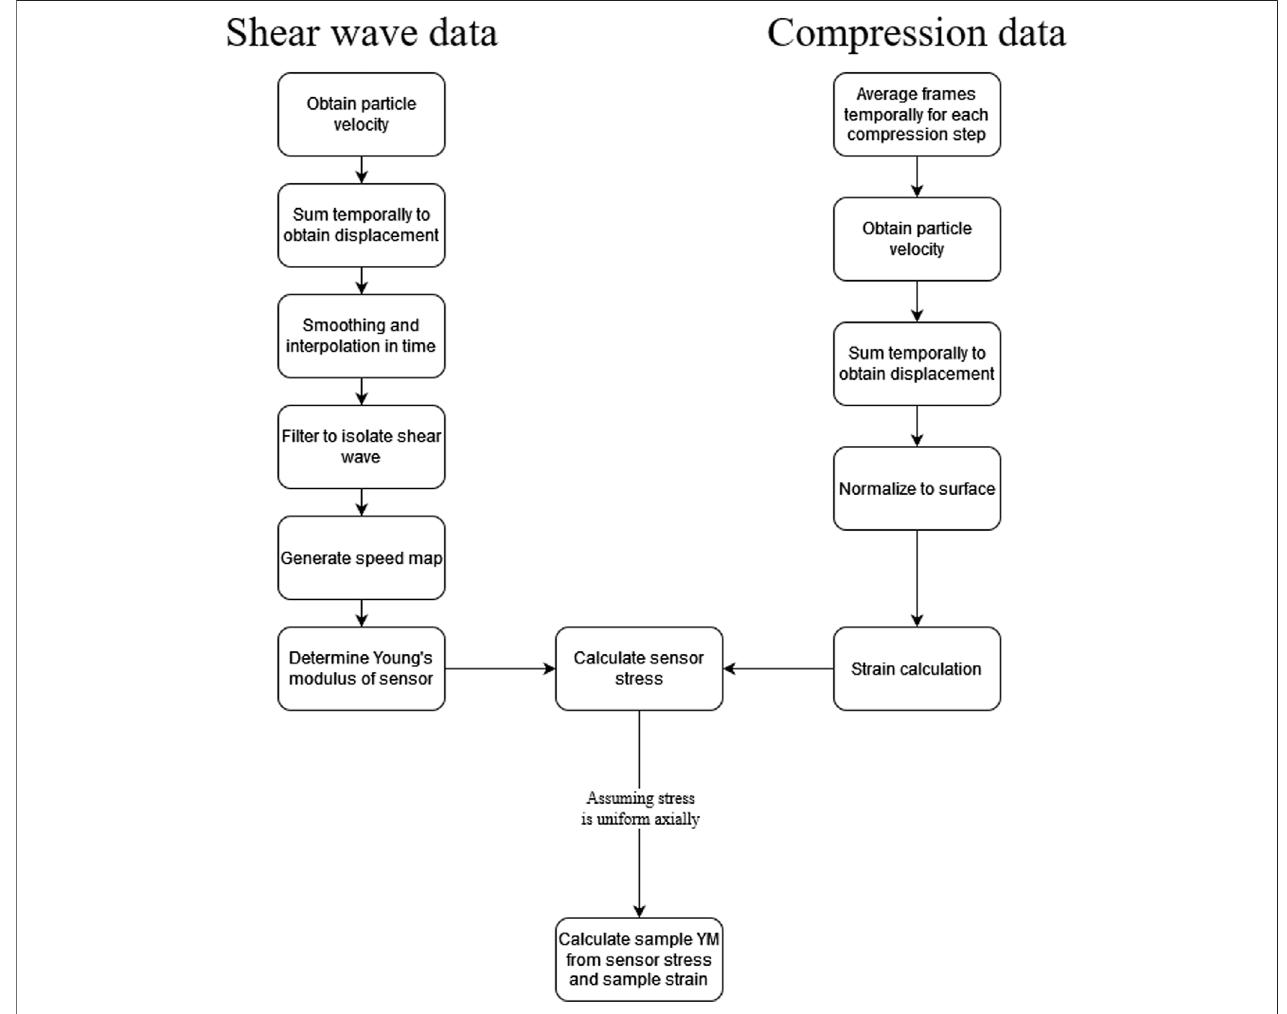
FIGURE 3 | Flow chart depicting the data processing